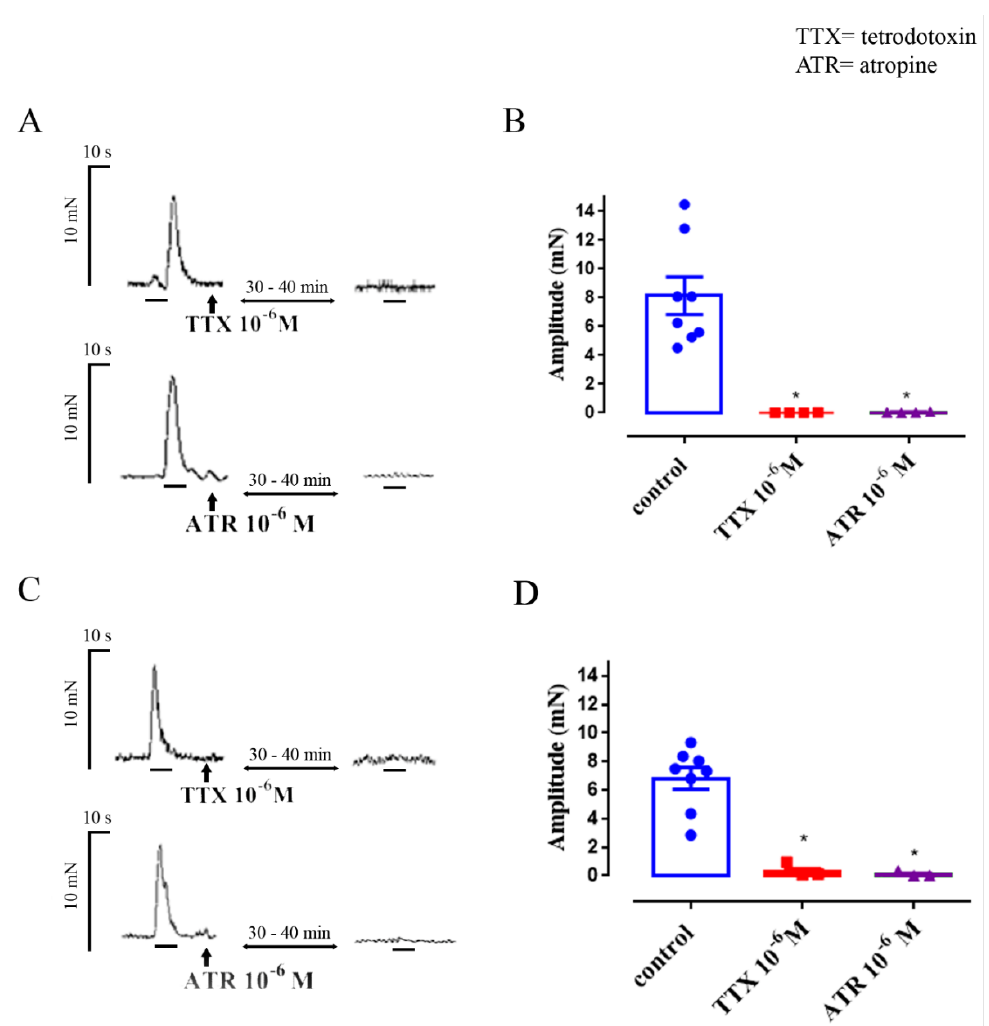
Figure 1. Inhibition by tetrodotoxin and atropine of EFS-evoked contractions of human and rat colon. The representative contraction evoked by EFS before and after administration of tetrodotoxin (TTX) or ATR is showed in panels ( A ) (human) and ( C ) (rat). Panels ( B ) (human) and ( D ) (rat) show the changes in the amplitude of EFS-contractions. Each point represents the mean of patients and animals studied: control n = 8, TTX n = 4, ATR n = 4 in human; control n = 8, TTX n = 4, ATR n = 4 in rat. Vertical lines show standard error of mean. EFS (frequency 5 Hz, pulse width 0.5 ms, for 10 s every 1 min). EFS = electrical field stimulation. * p ≤ 0.05 versus control ( t- tests).